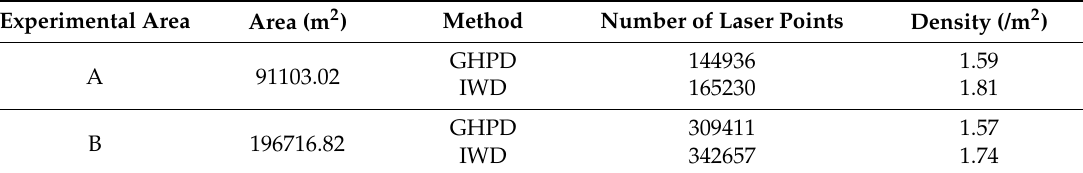
Table 6. The overall number and the local density of laser points.